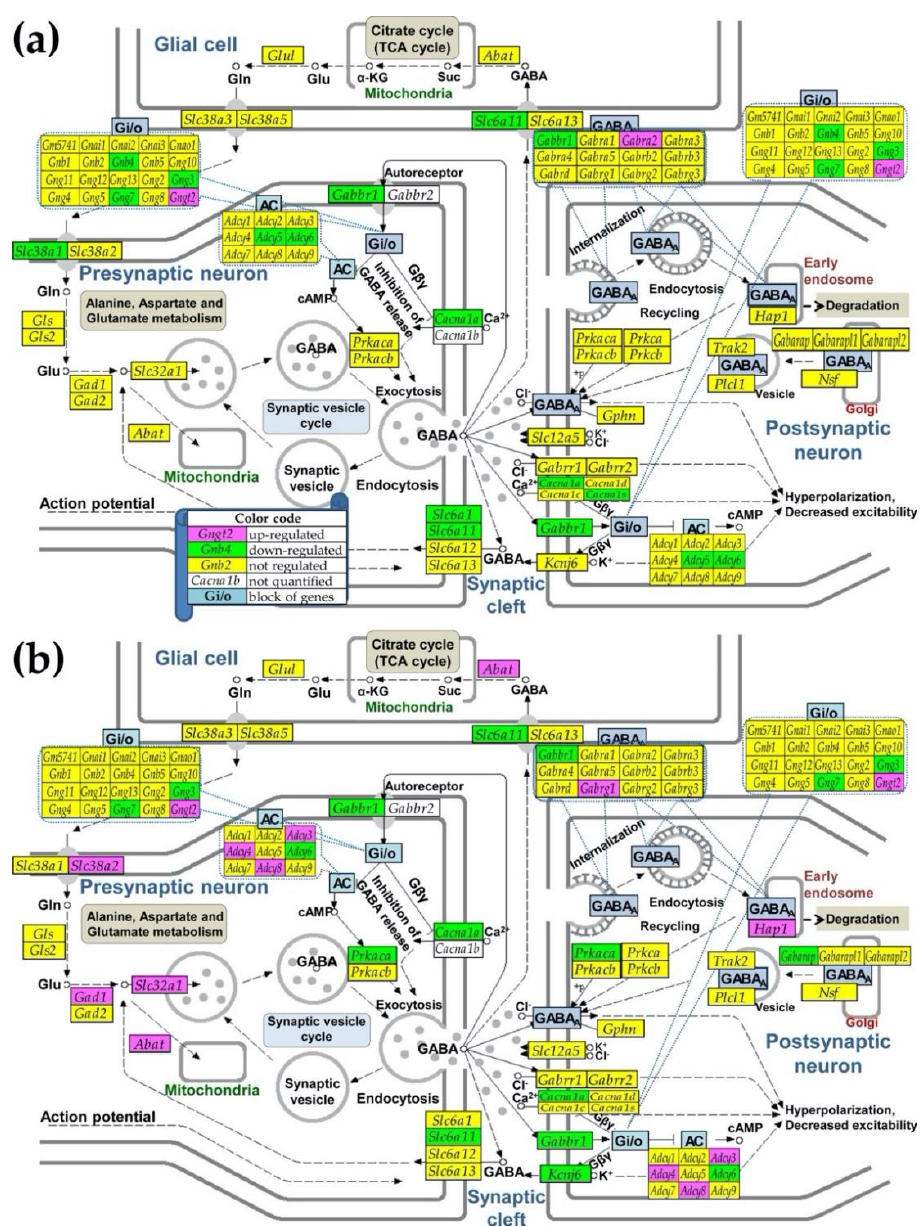
Figure 4. Regulation of the KEGG-determined GABAergic transmission in ( a ) Fn14ko and ( b ) MRL/ lpr with respect to MRL/ + . Owing to space constraints, some genes encoding proteins with similar functions were grouped in blocks denoted by KEGG as AC (adenylate cyclase), Gi/o (guanine nucleotide binding proteins), and GABA A (γ-aminobutyric acid receptors). Note the non-uniform (even opposite in some cases) regulation of genes from the same block.